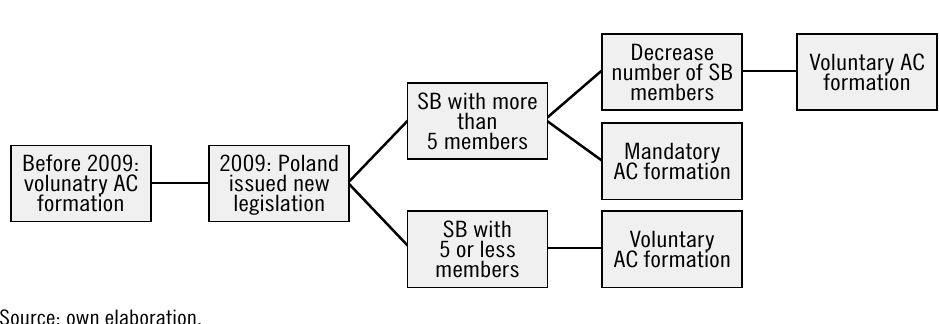
Figure 1. The reaction of Polish companies to the regulation changes